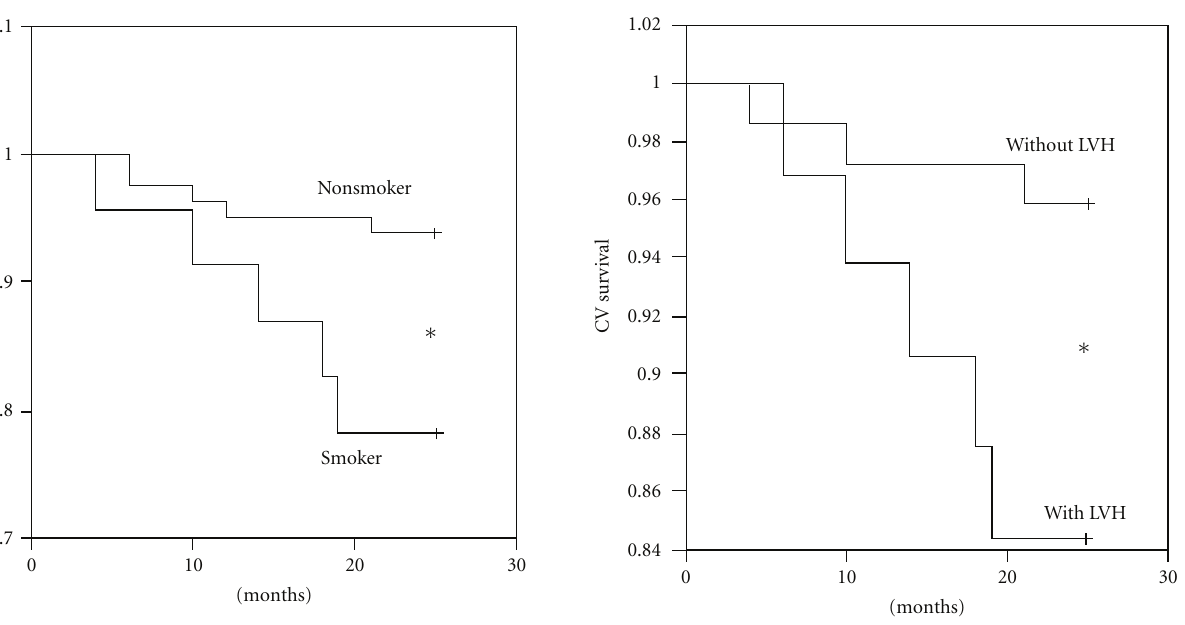
Figure 2: Kaplan-Meier analysis on whole hemodialysis patients showed that those without left ventricular hypertrophy (LVH) su ff ered cardiovascular death less than those with LVH. Log-rank test denoted that there was a significant di ff erence in cardiovascular mortality between patients with LVH and those